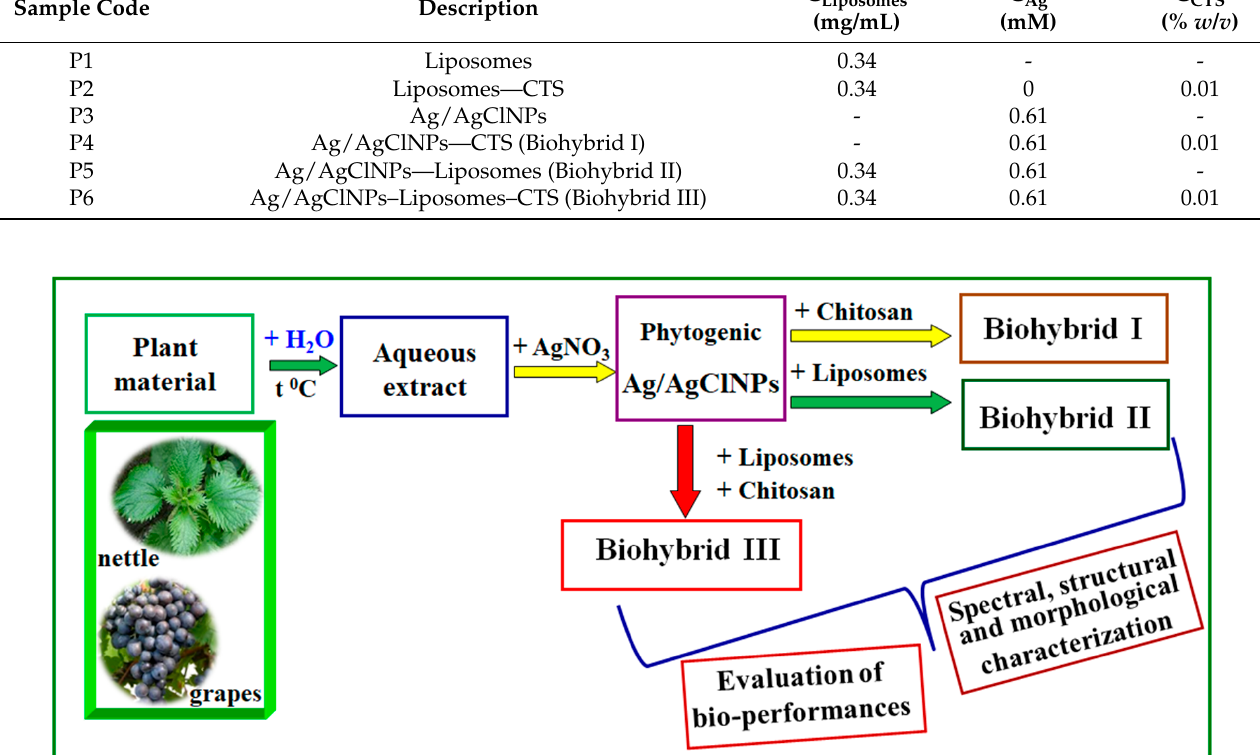
Figure 1. Schematic representation of the “green” development of biohybrids generated from nettle and grape extracts.